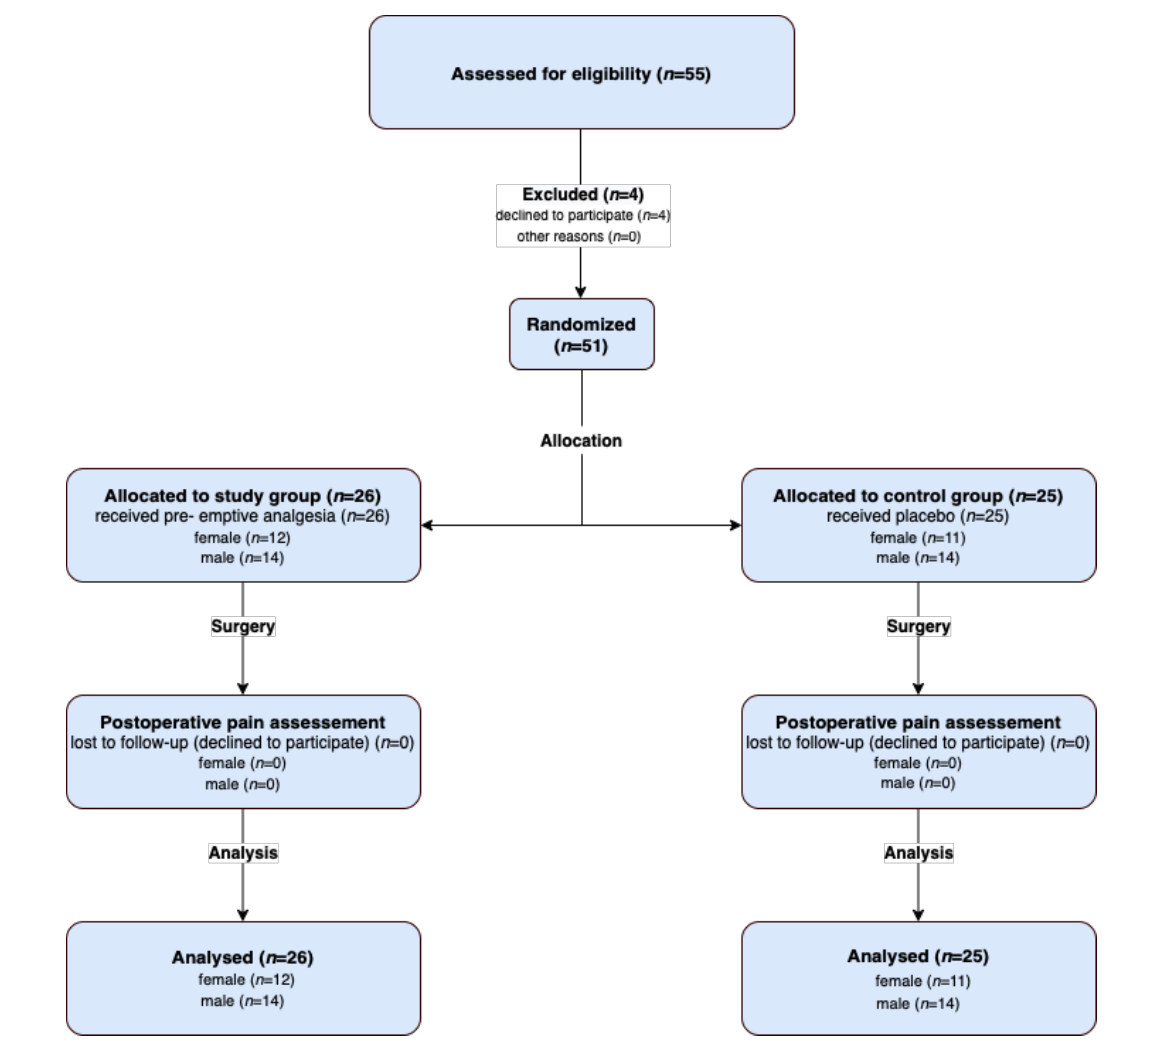
Figure 1. Flow diagram presenting the research participants.